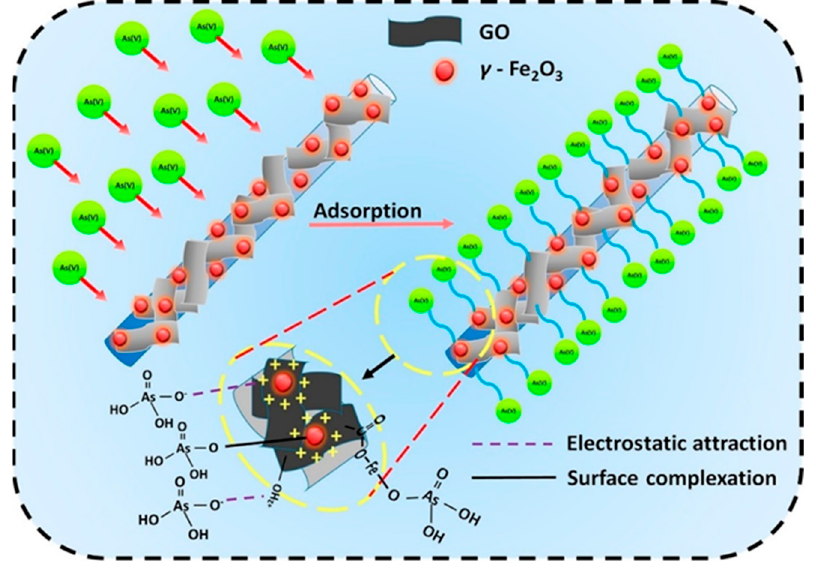
Figure 16. Schematic representation of possible adsorption mechanism for As 5+ removal on the surface of PAN/GO/ γ - Fe 2 O 3 nanofiber Membrane. Reproduced with permission from reference [124].